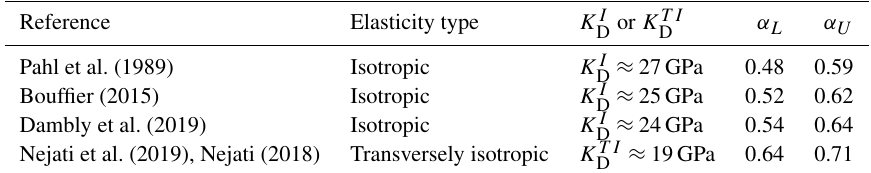
Table 9. Reduced data set for the upper and lower limits for the Biot coefficient for the Grimsel